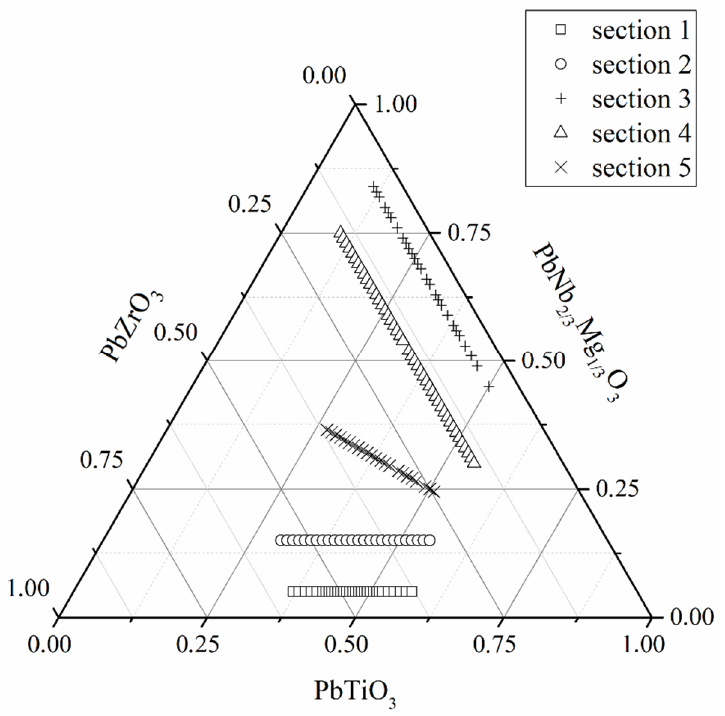
Figure 1. The studied cross-section of the PMN-PZT-PG system (Gibbs triangle).